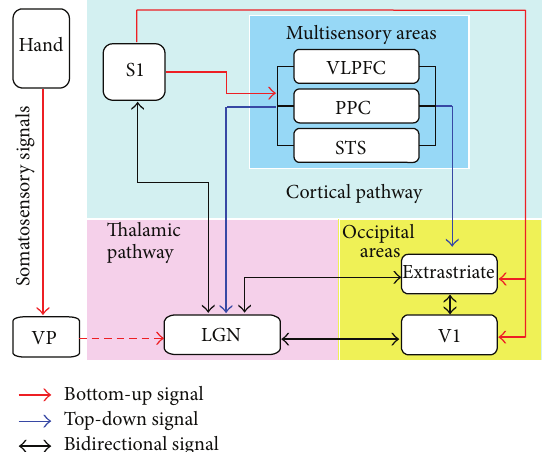
Figure 2: Schematic of neural pathways that convey somatosensory signals into visual areas. The solid line represents the existing connections in the normal sighted animals or human; dash line represents the rewired connections after early visual deprivation; arrows with red, blue, and black color represent the bottom-up, top- down, and bidirectional somatosensory signals, respectively. LGN: lateral geniculate nucleus; PPC: post parietal cortex; S1: primary somatosensory cortex; STS: superior temporal cortex; VLPFC: ventral lateral prefrontal cortex; V1: primary visual cortex; VP: ventral posterior